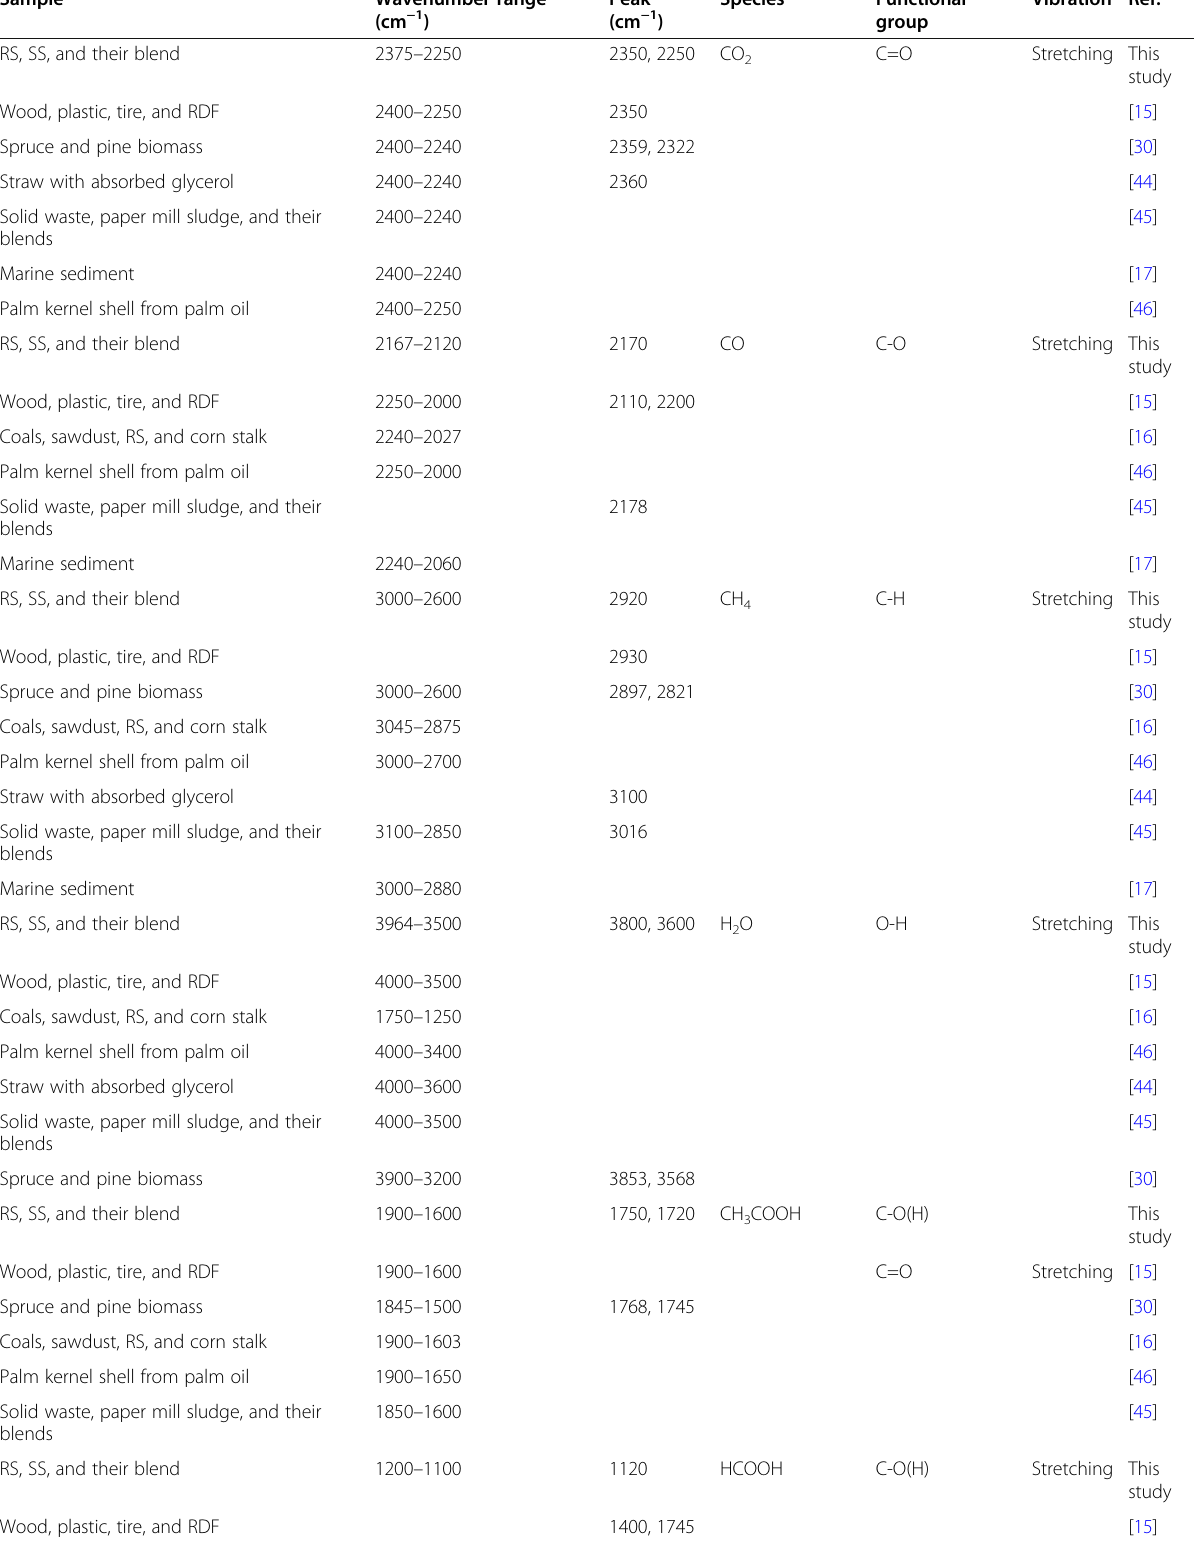
Table 4 Gaseous species based on wavenumbers (cm − 1 ) and functional groups for pyrolysis